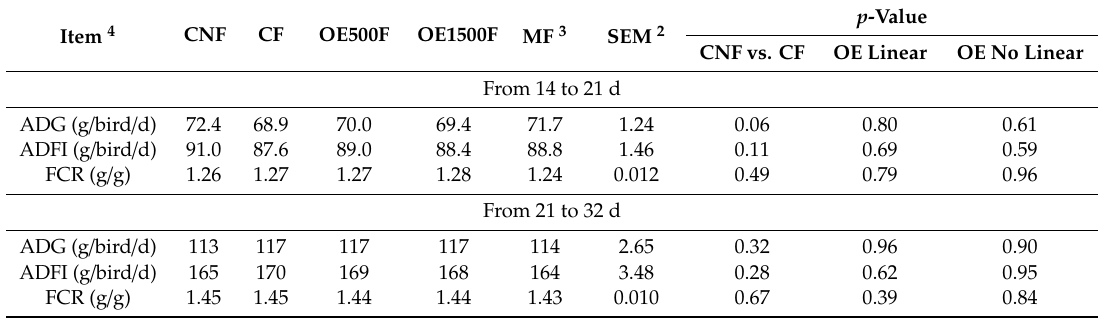
Table 3. E ff ect of experimental diets on broiler chickens growth performance from 14 to 32 d of age 1 .